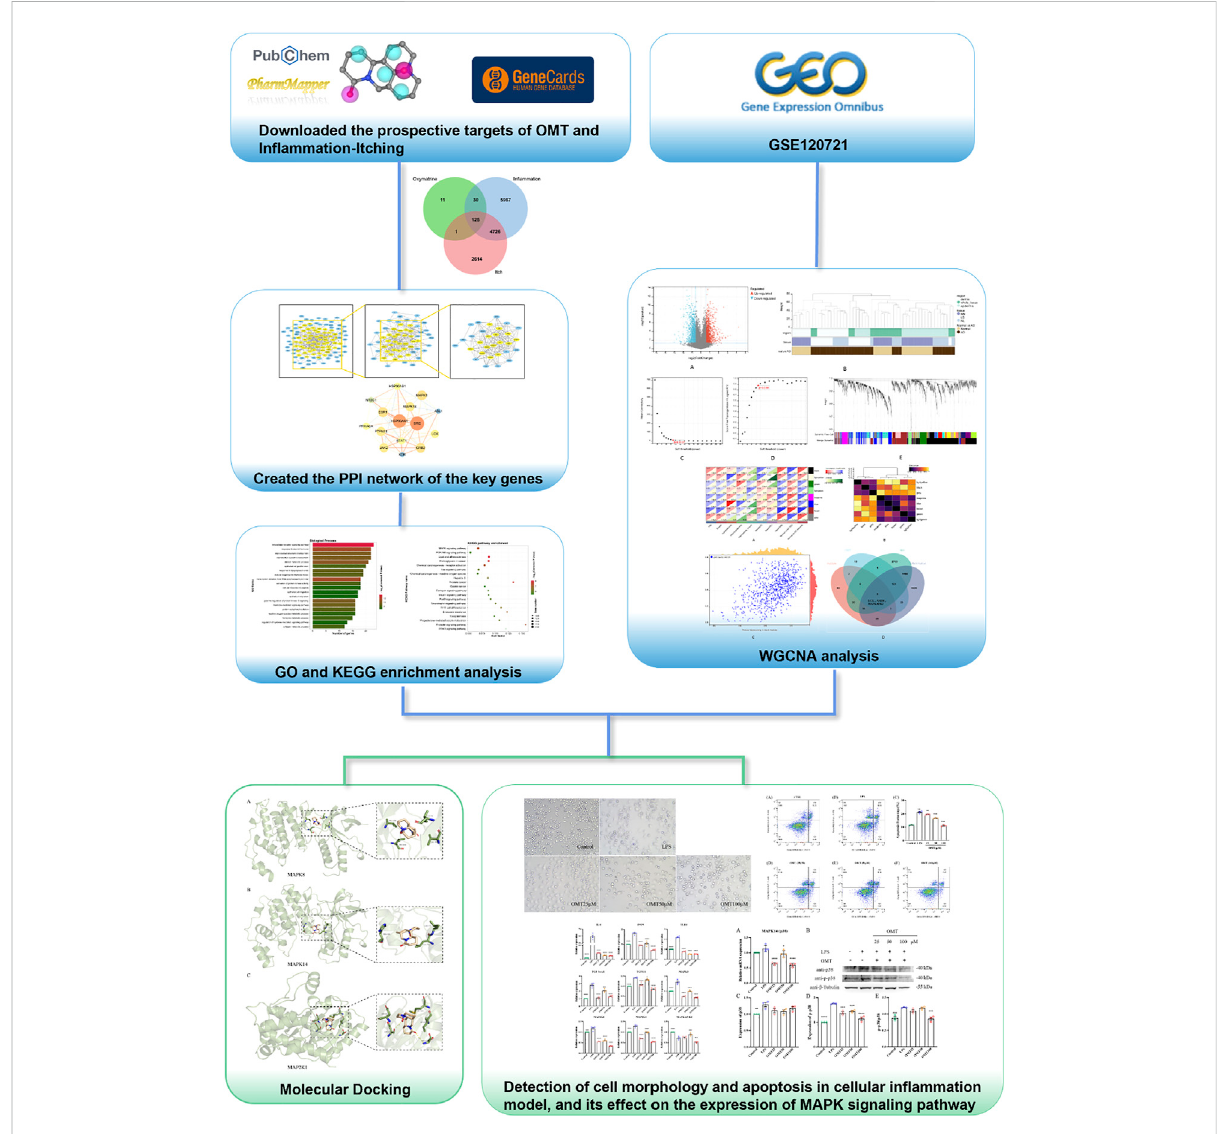
FIGURE 1 Thu fl ow chart of this slimly aims to investigate the potential mechanism of action of OMT in the liniment of pruritus.